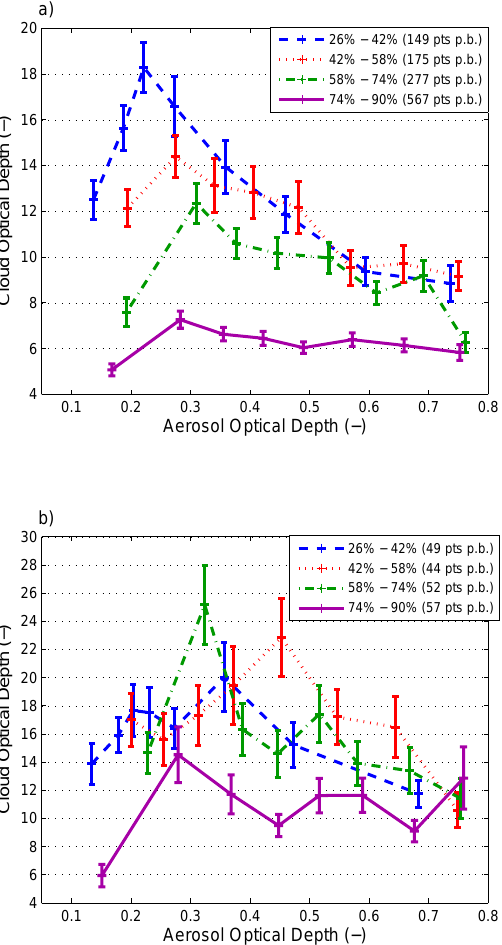
Fig. 6. (a) Liquid cloud optical depth binned by aerosol optical depth for all warm cloud retrievals, stratified by different percentile groupings of column water vapor. Data represent the months of Au- gust through October, for the years 2004 through 2007. (b) Same as (a) but only for retrievals with cloud top pressures between 800hPa and 850hPa. The number of retrievals included each bin is noted in the